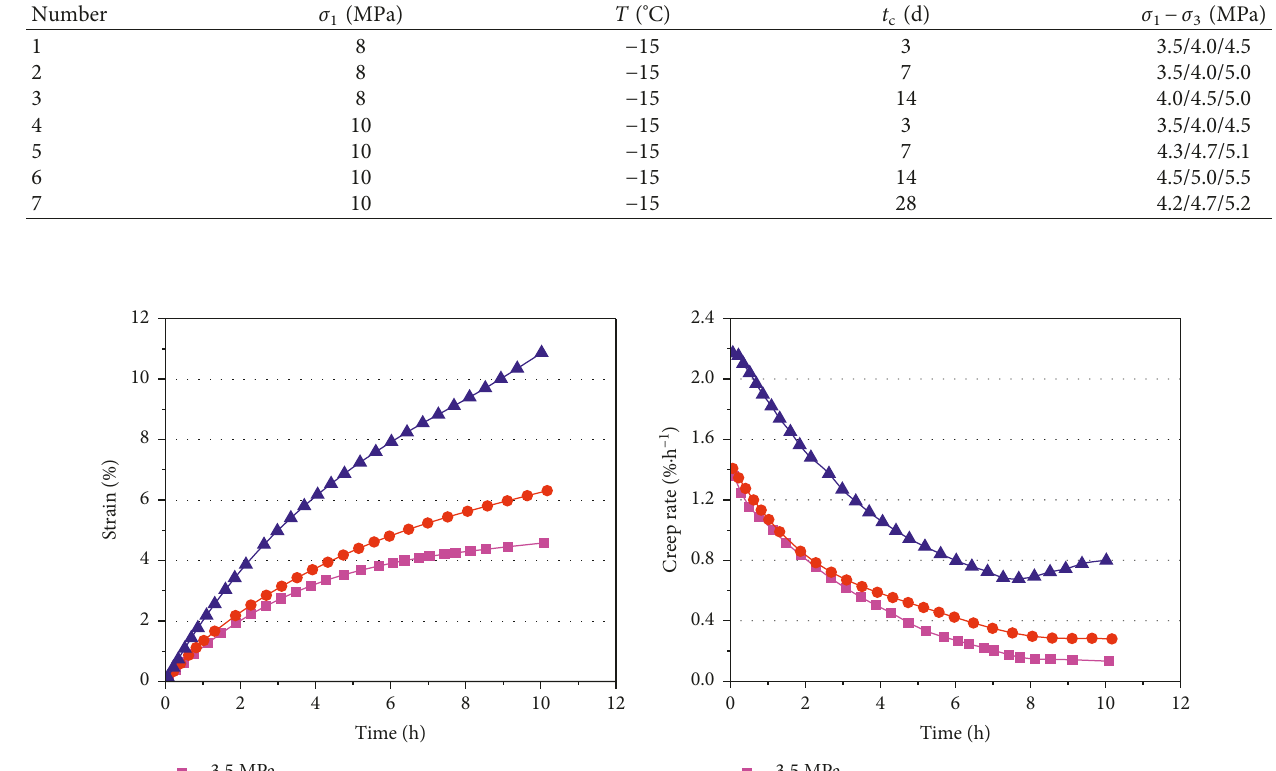
Table 2: Arrangements of triaxial unloading creep test on frozen